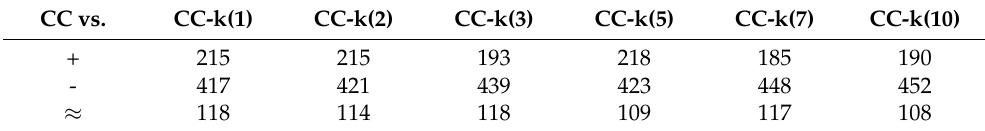
Table 2. The Wilcox rank-sum test CC vs. CC-k(v). CC vs.